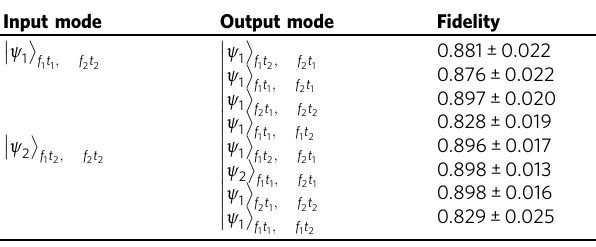
Table 1 Fidelities of qutrit states after temporal and spectral manipulations